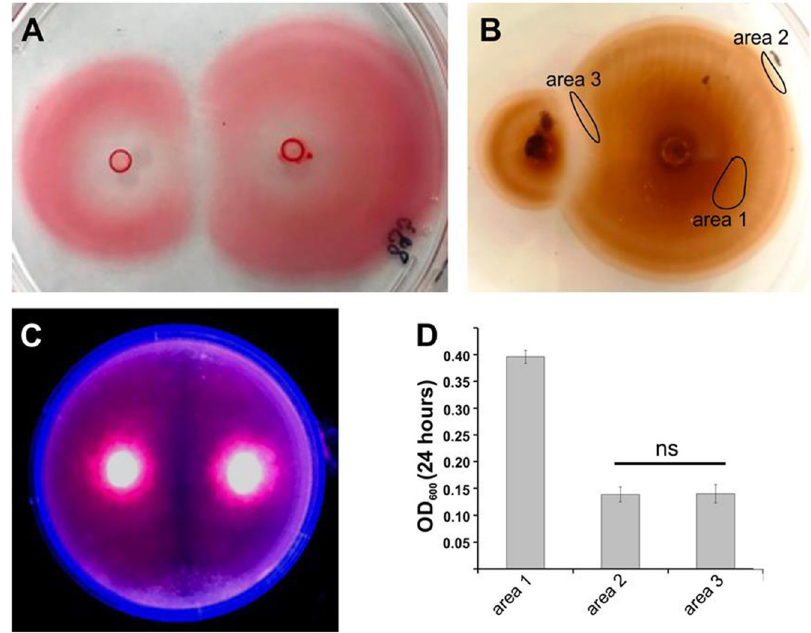
Figure 2. Metabolic activity and viability of motile M. algicola DG893 cells. To assess whether the motile cells were metabolically active. Agar plates were overlaid with either triphenyltetrazolium chloride ( A ), or diaminobenzidine and H 2 O 2 ( B ), to visualize succinate dehydrogenase or peroxidase enzymatic activity, respectively. Non-stained regions are considered as metabolically inactive. Propidium iodide (PI) is known to incorporate into dead or permeable cells, thus the lack of staining shows that the cells near the inhibition zone are still viable ( C ). To verify viability of cells from different zones (marked on section B), their growth after 24 h was measured by OD600. For each area, mean ± SD for n ≥ 5 probing spots are presented ( D ); ns, not significant.